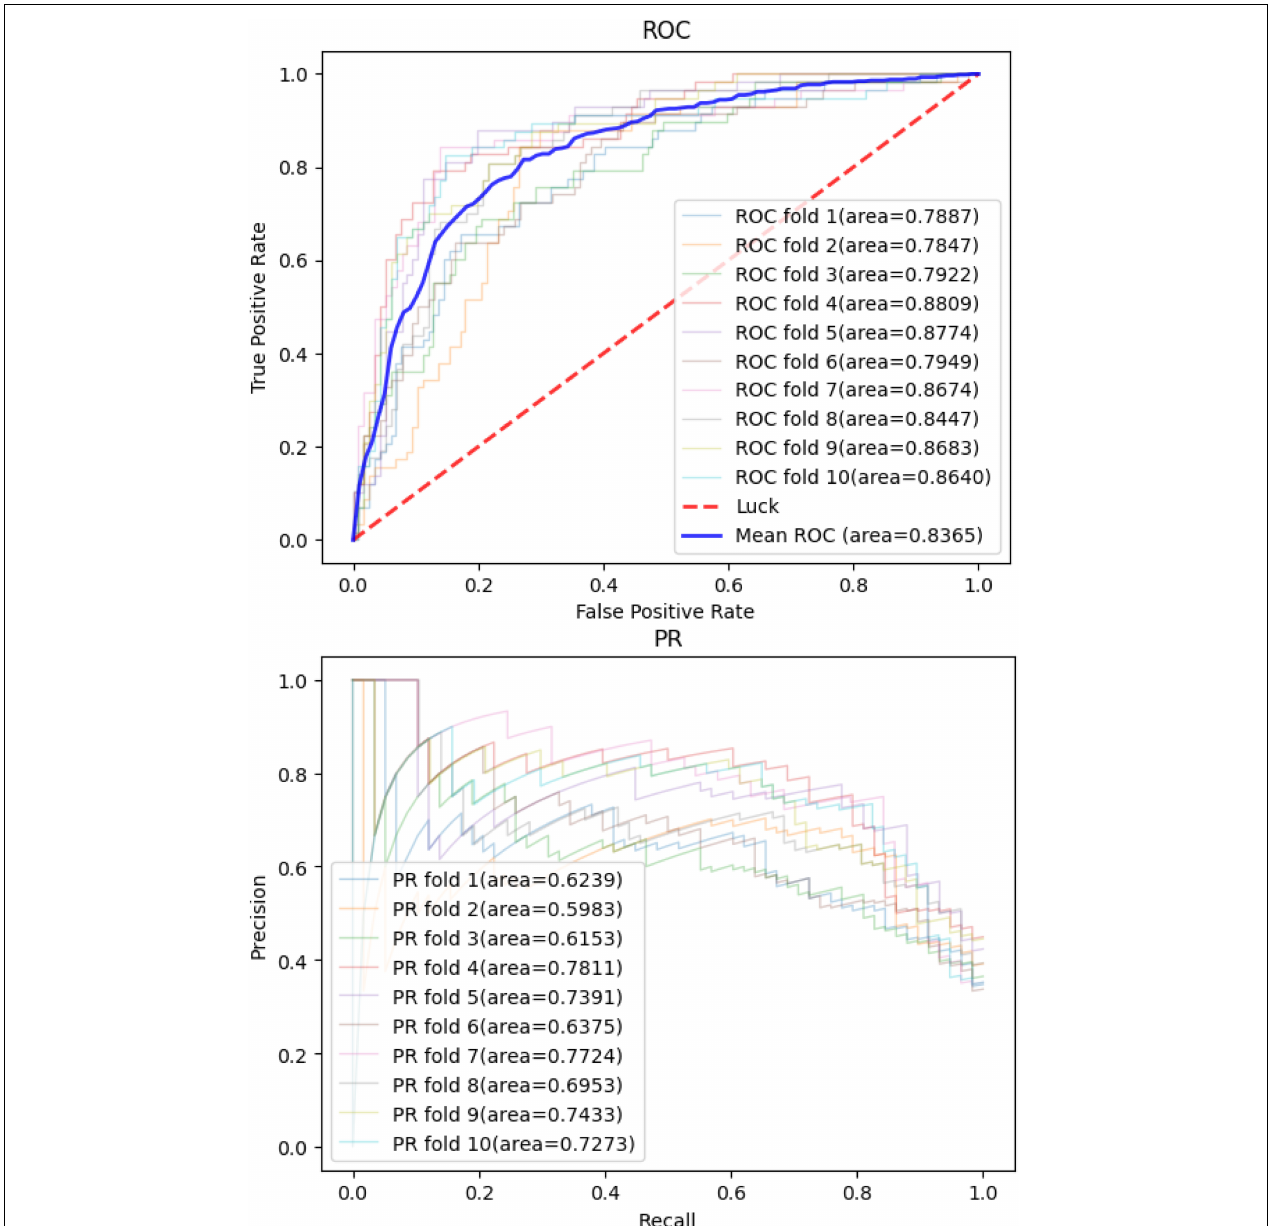
FIGURE 3 | Convolutional neural network model’s receiver operating characteristic curve and precision recall curve in 10-fold